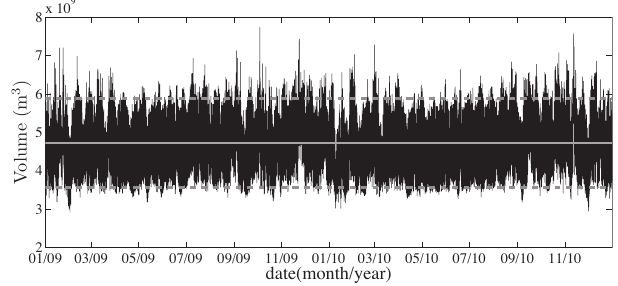
Figure 12. Time series of the volume inside the WDWS (black line). The grey line represents the mean volume over the period 2009– 2010. The dashed grey lines represent the average maximum and minimum volumes over the period